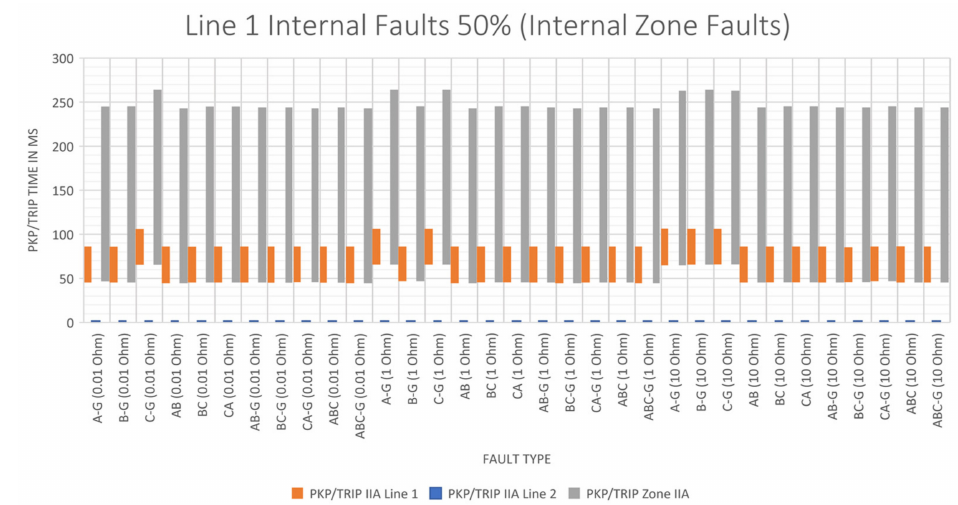
Figure 25. Internal line faults in Line 1 (50%); two reactors.